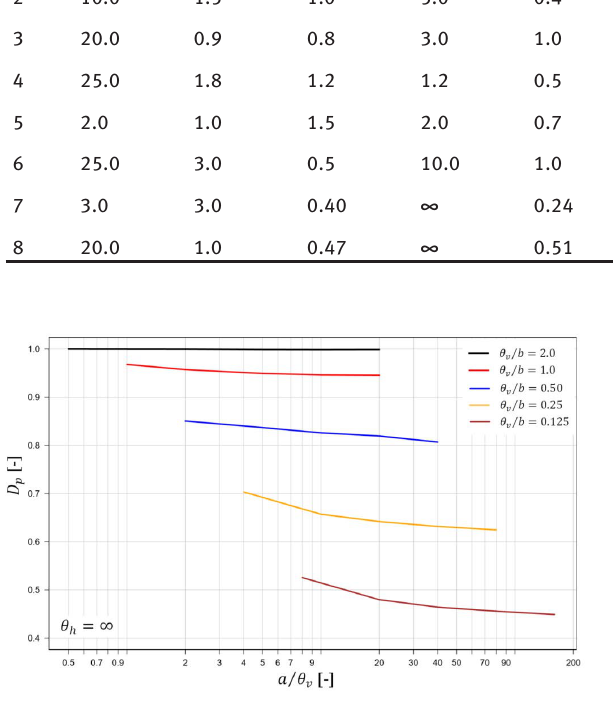
value for an infinite horizontal p